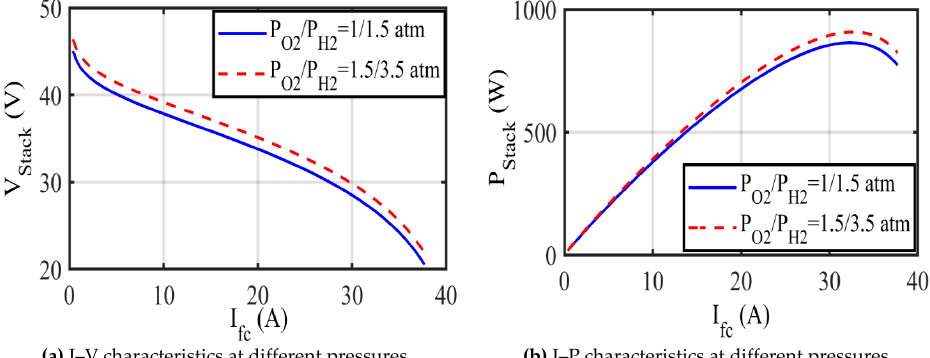
Figure 6. Characteristics of SR-12 at different pressures.